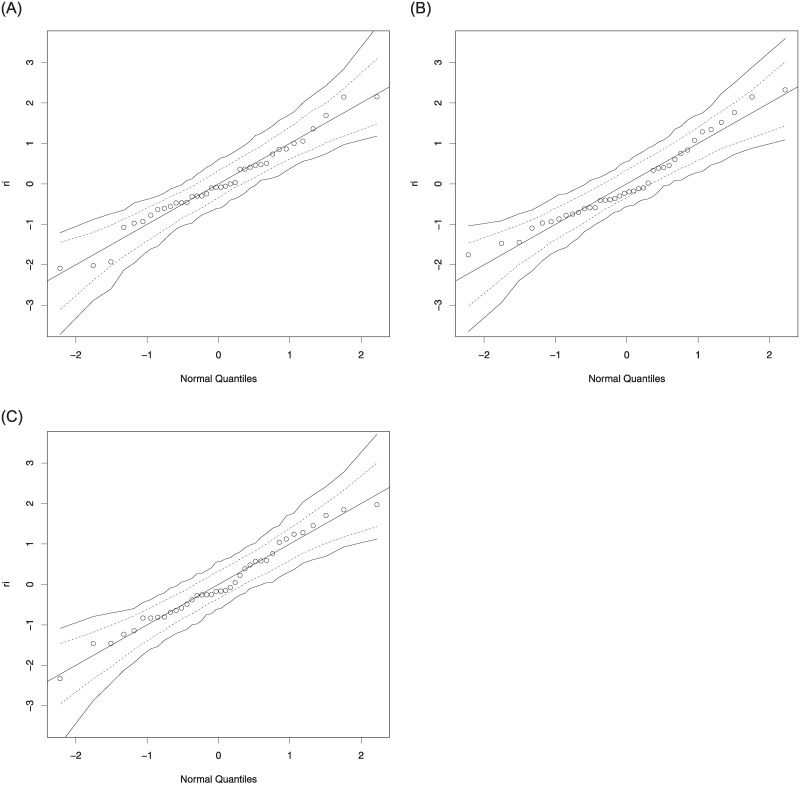
The quantile-quantile plots of the randomized quantile residuals: Beta (left), unit-Lindley (middle) and log-Bilal (right).